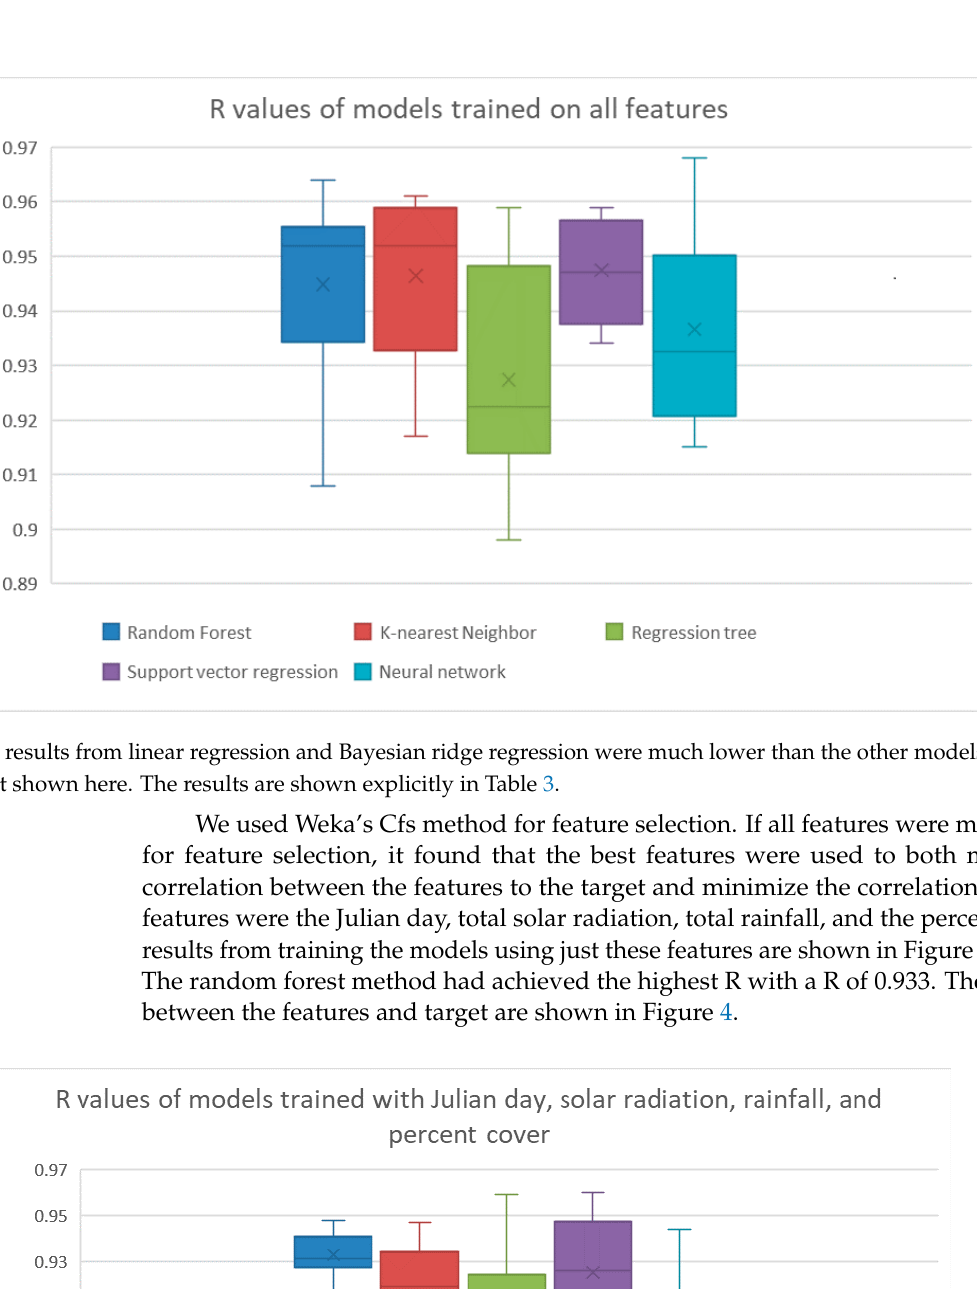
the features Julian day, total solar radiation, total rainfall, and percent cover.